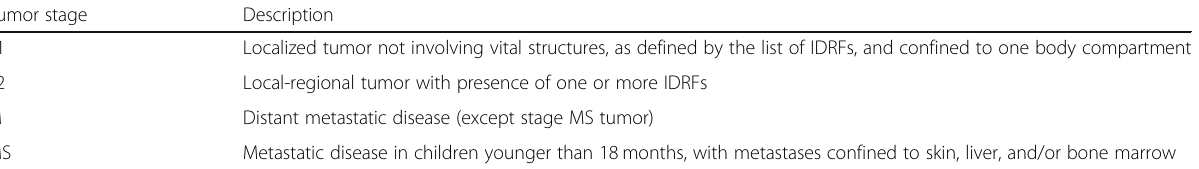
Table 2 Descriptions of INRG tumor stages [6] Tumor